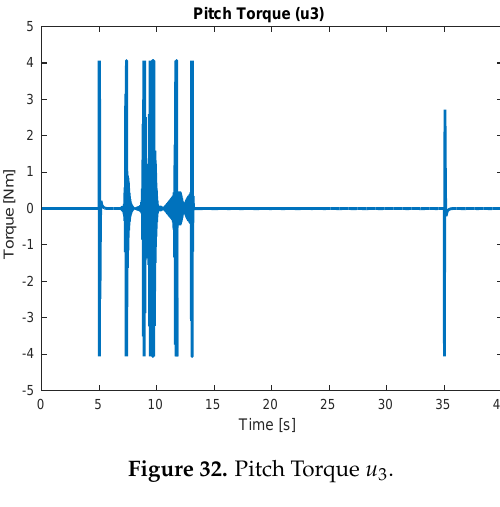
Figure 32. Pitch Torque u 3 .